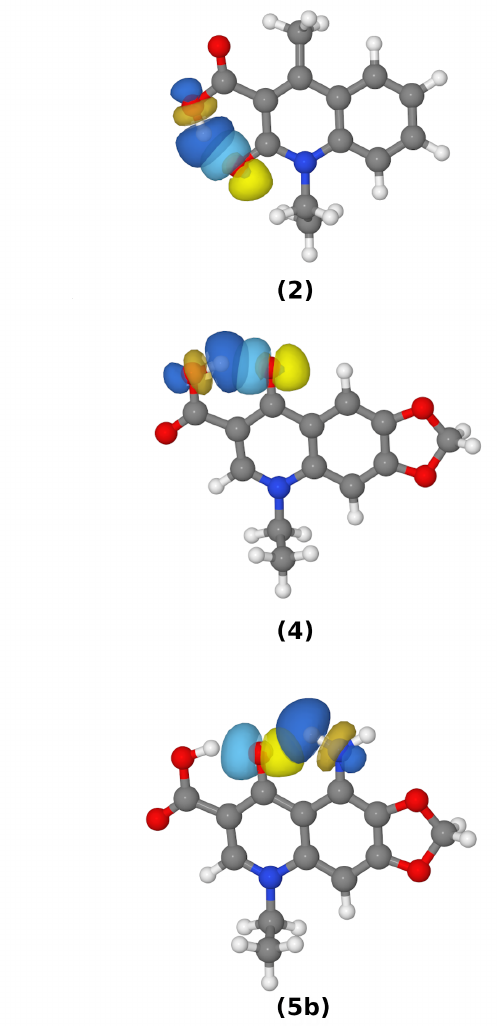
Figure 3. Natural bond orbitals of oxygen atoms LP(2) and the respective O–H/N–H σ ∗ orbitals (N–H in the case of Compound 5 containing two intramolecular hydrogen bonds). The 5a and 5b labels indicate the presence of two intramolecular HBs in Compound 5